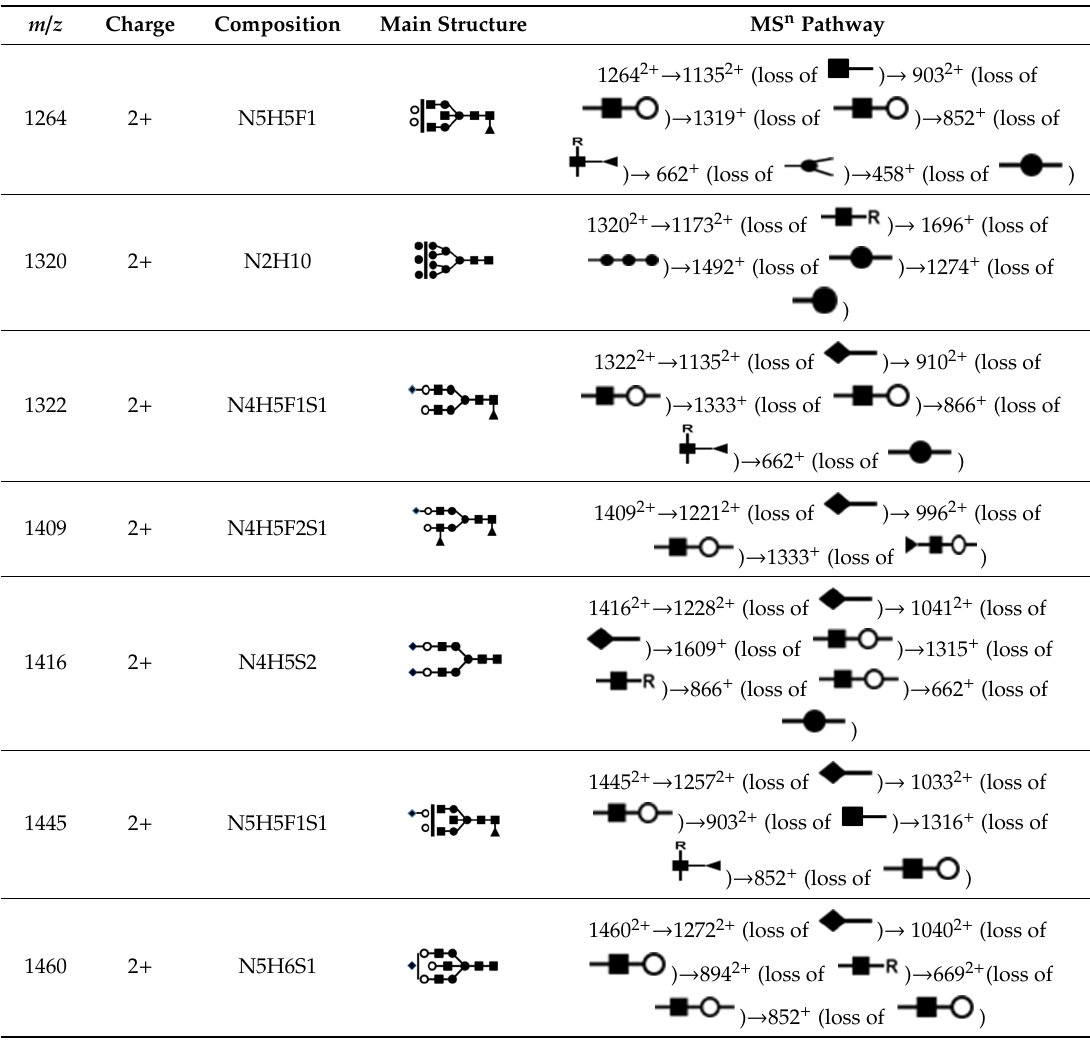
Table 1. Major N-glycans in sera of healthy controls and rheumatoid arthritis patients.